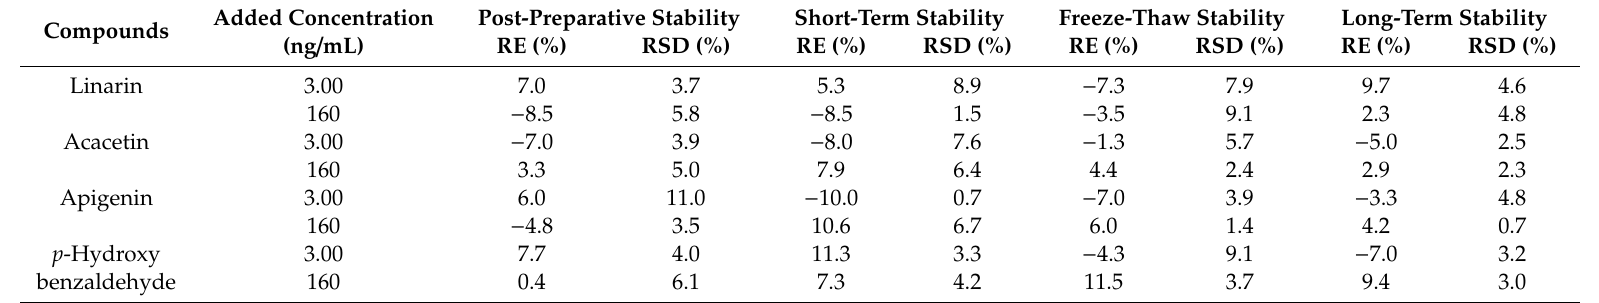
Luteolin-7- O -glucopyranoside (IS) Table 4. Stability of linarin, acacetin, apigenin, and p -hydroxy benzaldehyde in rat plasma. Added Concentration Post-Preparative Stability Short-Term Stability Freeze-Thaw Stability Long-Term Compounds